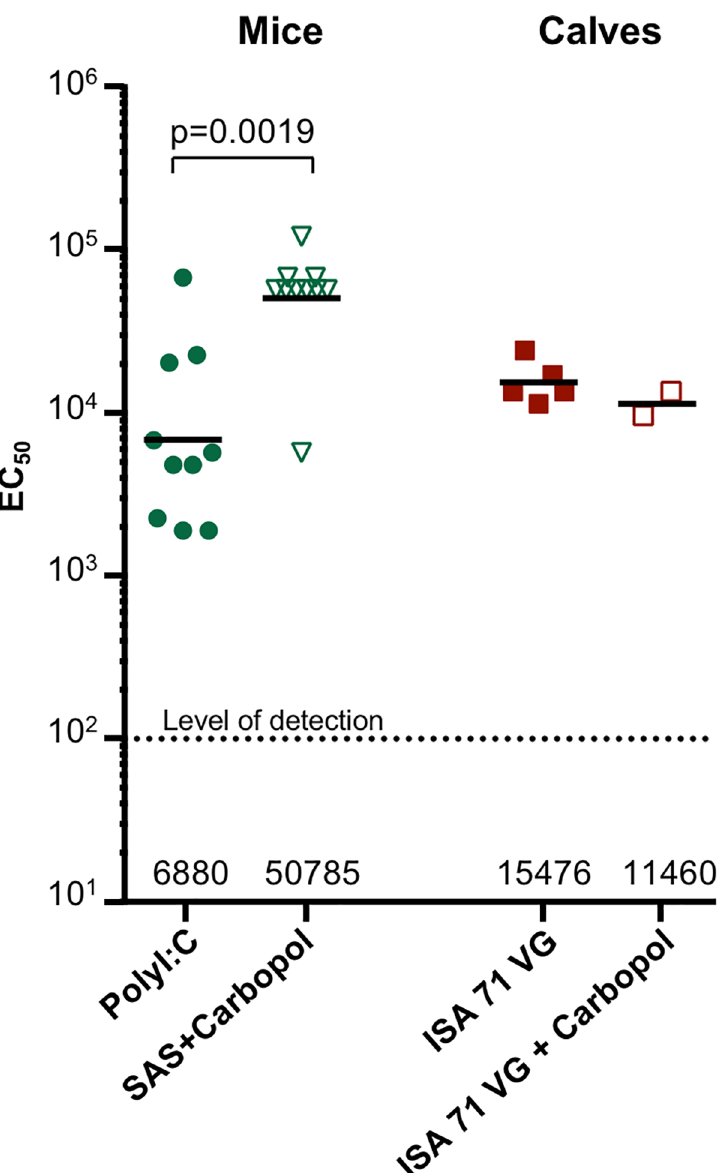
Fig 7. Bovine pre-fusion RSV F response in mice and cattle. Pre-F bovine RSV F DS-Cav1 formulated with two adjuvantswas used to immunize mice and calves and resulted in high neutralization titers. Mice were administered DS-Cav1 formulated with Poly(I:C) and SAS + Carbopol, whereas,cattle were administered with an analogous water in oil emulsion,ISA 71 VG-DS-Cav1 formulation and ISA 71 VG + Carbopol–DS-Cav1 formulation. Scatter plots show the geometric mean (numericalvalue below), each group included10 mice and 2–5 calves. Level of detectionis indicatedby a dotted line; and p value for SAS + Carbopol/DS-Cav1 versus the Poly (I:C) formulations in mice as assessedby two-tailedMann-Whitney test is shown; p = 0.0019. (Controlgroups without Carbopol were reportedpreviouslyin ref. [36]). Th1/Th2 response. High titer neutralizing antibodies have been reported with a balanced Th1/ Th2 response when mice were immunized with reconstituted virosomes produced from RSV envelopes containing a lipopeptide adjuvant [48]. In contrast, to the Th2-biased response induced by DS-Cav1 with Adjuplex, a balanced Th1/Th2 response was obtained when mice